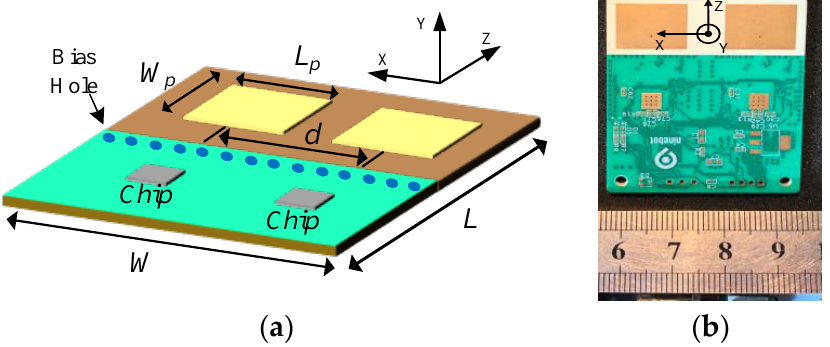
Figure 20. Structure of proposed anchor antennas. ( a ) Diagram of the patch array. ( b ) Photograph of the patch array and UWB chips.